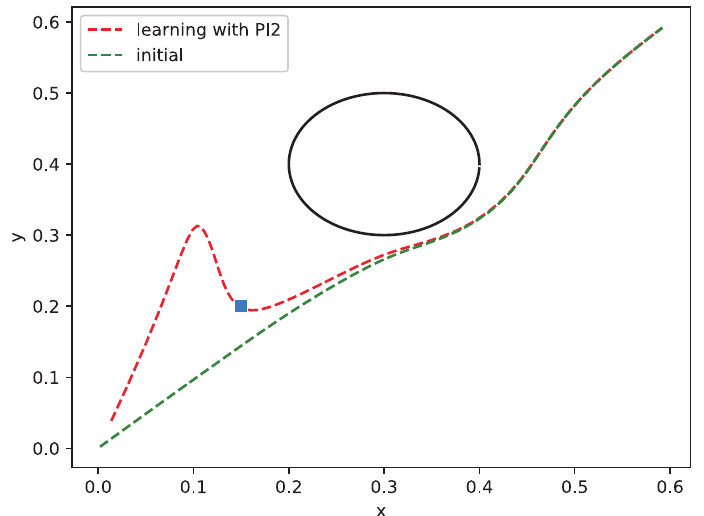
Figure 5. Obstacle avoidance behavior with different values of λ .